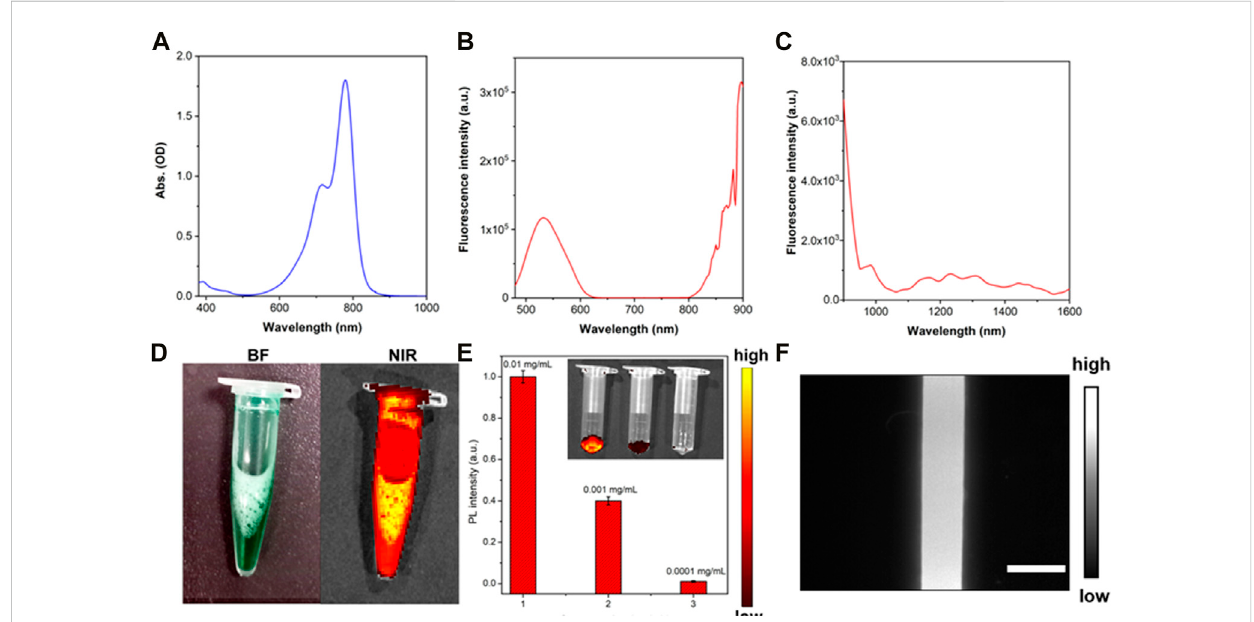
FIGURE 2 Characterization of clinical ICG. (A) Absorption spectrum, (B) NIR-I fl uorescence spectrum ( λ excitation = 450 nm), and (C) NIR-II fl uorescence spectrum of ICG in the FBS ( λ excitation = 645 nm). (D) NIR-I fl uorescence images of ICG in the FBS, (E) NIR-I fl uorescence intensity of ICG in the FBS at differentconcentrations(0.01 mg/mL,0.001 mg/mL,and0.0001 mg/mL). λ excitation =745 nmand λ emission =840 nm.Inset:NIR-I fl uorescenceimagesof ICG (in FBS) with different concentrations of 0.01 mg/mL, 0.001 mg/mL, and 0.0001 mg/mL. (F) NIR-II fl uorescence microscopic images of ICG in the FBS under an 808 nm laser